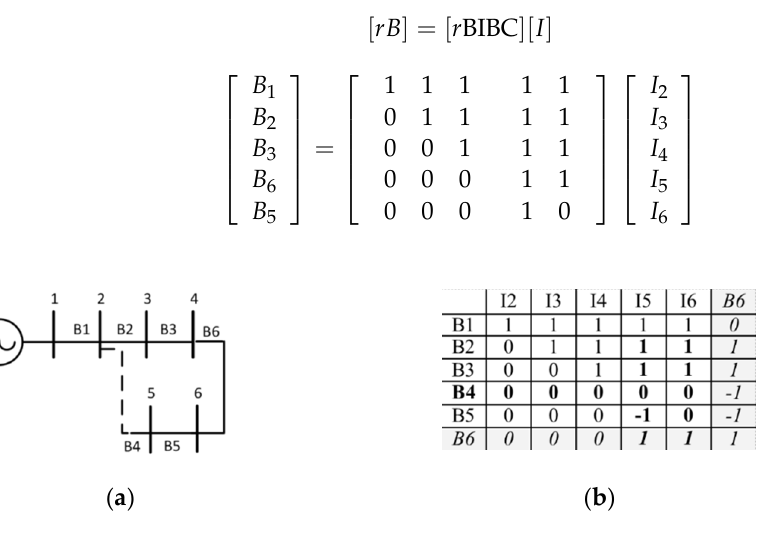
Figure 3. The 6-bus system new configuration ( a ) and BIBC matrix ( b ). Given procedure above can be implemented as follows: Branch to close, B cl , between bus j and k, is selected. A temporary vector, temp , is obtained with subtracting I k column of (cid:0)(cid:2) (cid:3) − [ (cid:1) I j I k ] BIBC from I j column . To keep radiality, one of the branches of the loop should be opened ( B op ). In BIBC matrix, an XOR operation is performed between B op row and the nonzero rows of tmp that give the branches of the loop. Finally, in r BIBC matrix name of the opened branch is exchanged with closed one, B cl . For the system in Figure 1a, branch to close ( B cl ), B6 , is connected from bus 4 to bus 6 and tmp vector is obtained as in Figure 4. B4 is selected as branch to open B op and XOR operation is done between B4 row and B2, B3 , B5 which are nonzero rows of tmp vector. Opened branch B4 is changed to closed branch B6 , and the r BIBC matrix is obtained as in Figure 4.